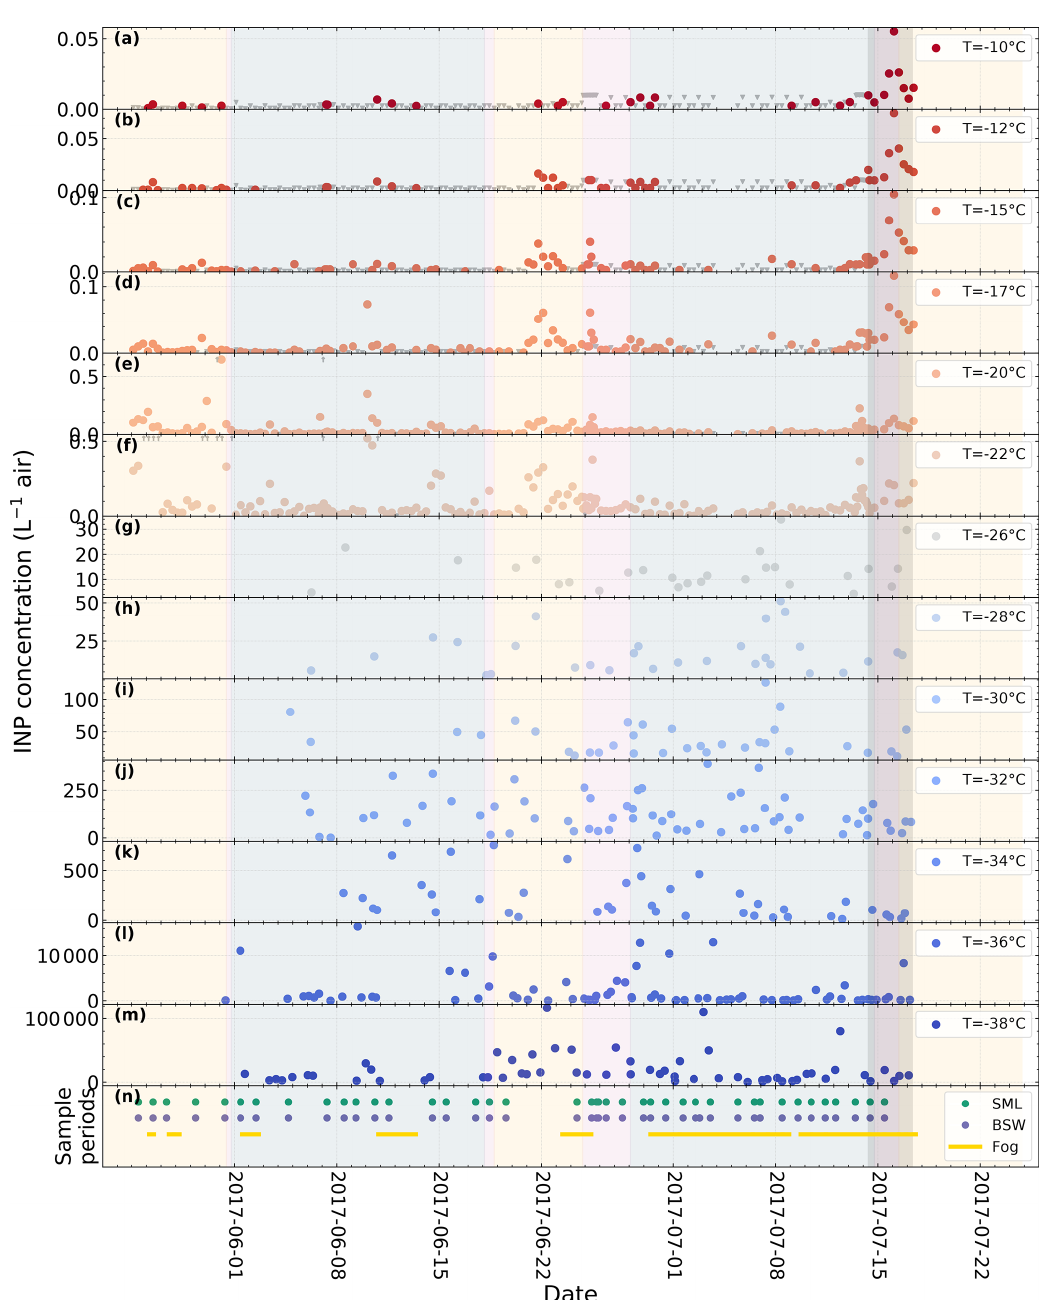
Figure 2. Time series of atmospheric N INP at different temperature derived from filter samples with LINA ( − 22 ◦ C and above) and SPIN measurements ( − 26 ◦ C and below). The bottom panel contains markers for the sample collection times of the SML, BSW, and fog water samples. The shaded areas indicate the environment that the vessel is located in (yellow = ice-free ocean; blue = within ice pack; pur- ple = marginal ice zone). The dark gray area indicates the period of the case study discussed in Sect. 3.5. Note that SPIN measurements were only obtained beginning with 31